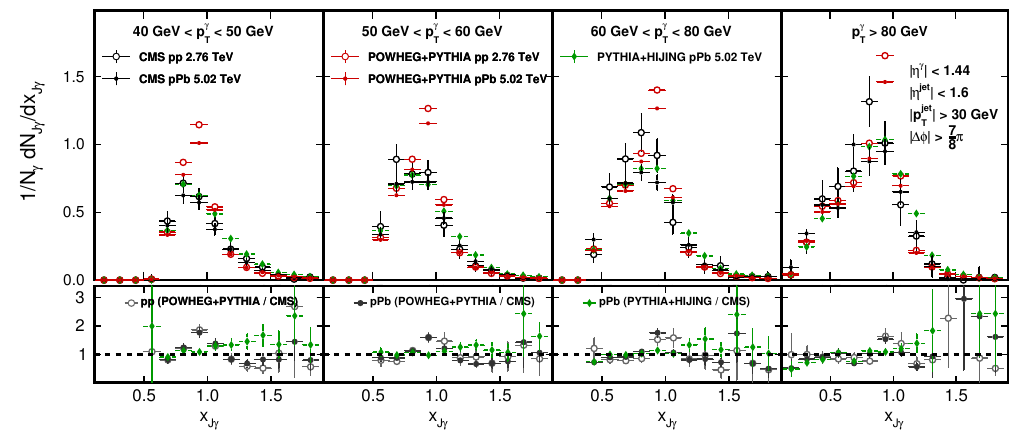
Figure 4 . Distributions in the transverse momentum ratio of jets over photons in pp (open circles) and pPb (full circles) collisions at the LHC with a centre-of-mass energy per nucleon of and 5.02 TeV, respectively, in four di(cid:11)erent bins of photon transverse momentum. CMS 2013 data (black) are compared to predictions in LO with PYTHIA+HIJING (green) and NLO+PS with POWHEG+PYTHIA (red). The lower panels show the ratios of theory over data for pp (open circles) and pPb (full circles and green